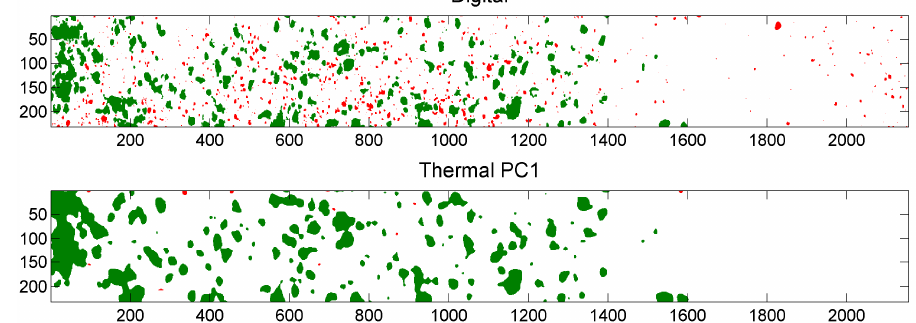
Figure 9. Binarized digital image ( top ); and binarized thermal output image “PC1” ( bottom ). Coordinates are shown in pixels. Particles that occur in both images are shown in green. Particles that occur only in the digital image or only in the thermal output image are shown in red in respectively the top image and the bottom image.